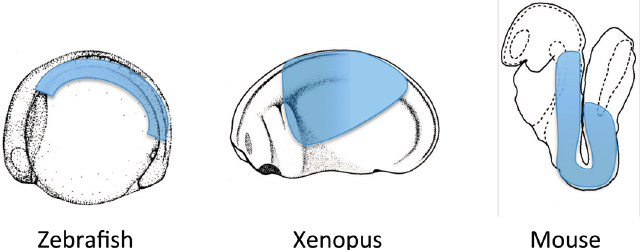
Figure 2. Retinoic acid activity varies along the anterior-posterior axis but does not form a precise gradient along the entire axis. Using either Aldh1a2 expression or reporters of RA activity, the regions showing RA activity (shown in light blue overlapping an embryo schematic) are roughly in the middle of the embryo with notable absence of signaling at the most anterior and posterior ends of the